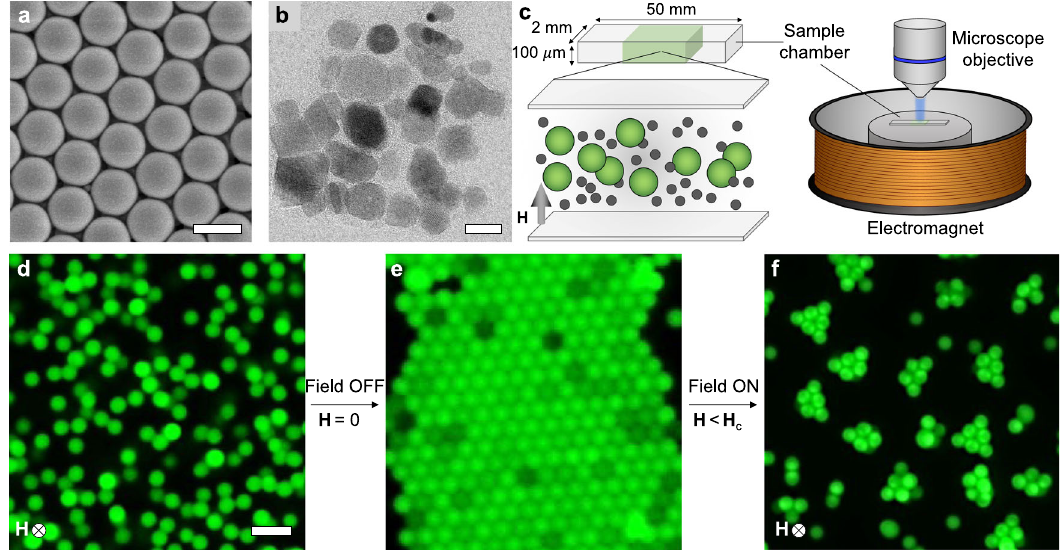
Fig. 2 Experimental setup and main observations. a Scanning electron microscopy image of the PS microparticles used. Scale bar: 2 μ m. b Transmission electron microscopy image of Fe 3 O 4 nanoparticles responsible for the short-range depletion attraction and long-range magnetic repulsion responsible for assembly of the PS microparticles. Scale bar: 20 nm. c Schematic of the experimental setup comprising a sample chamber placed in the center of an electromagnetic coil under the microscope objective. The sample is the binary suspension of PS microparticles and Fe 3 O 4 nanoparticles enclosed in a fl at glass capillary which is sealed at both ends. d – f Fluorescence microscopy images of unassembled microparticles, assembled crystal and clusters. Scale bar: 5 μ